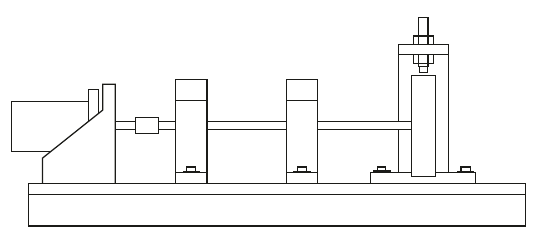
Figure 12: Simulate the pump shaft structure of the plastic cen- trifugal pump on test stand.